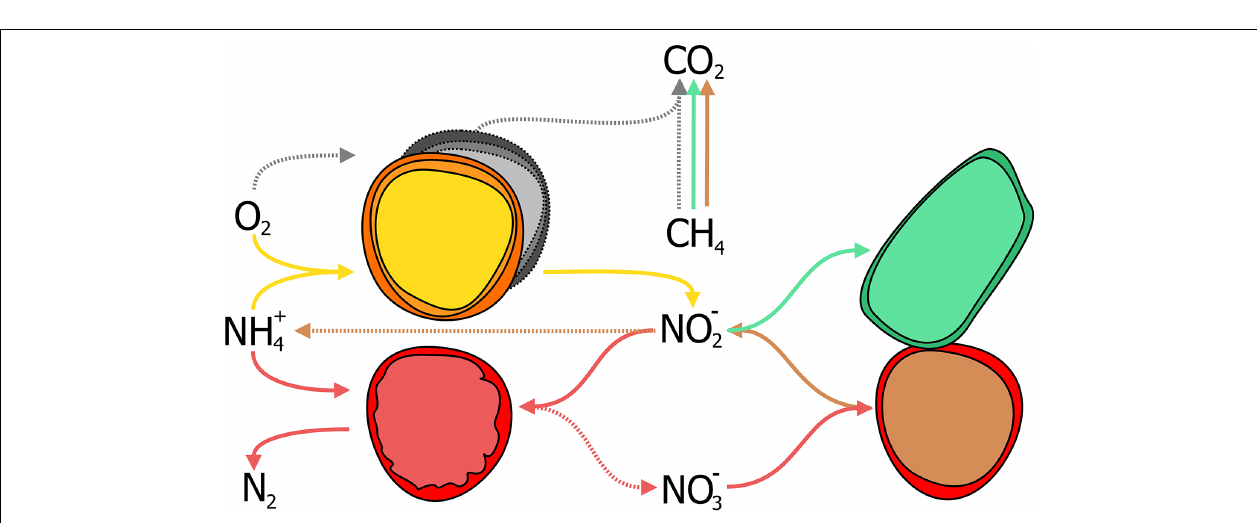
FIGURE 6 | A schematic representation of the combination of partial-nitritation/anammox (PN/A) and N-dAOM processes in WWT. (A) Canonical denitrification where space, energy, and organic carbon, are needed for complete nitrogen removal in WWT. Denitrification produces sludge and GHG emissions as by-products under unfavorable conditions. (B) Partial-nitritation/anammox process, as a short cut to complete denitrification. AOB (in yellow) oxidize ammonia to nitrite, anammox bacteria (in red) oxidize ammonia anaerobically using nitrite as electron acceptor. (C) Incorporation of N-dAOM processes to PN/A, where both achieve the simultaneous removal of ammonia and methane (represented in green and blue for nitrate- and nitrite-dAOM, respectively). Broken arrows indicate competing processes that are deemed undesirable or processes that are circumvented by the implementation of the PN/A and N-dAOM processes. Adapted from Guerrero-Cruz (2018).